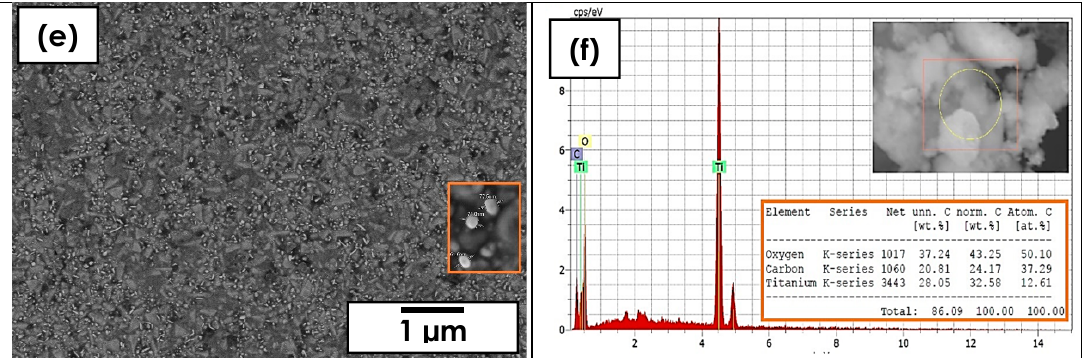
Figure 4. FESEM images of ( a ) graphite, ( b ) GO, ( c ) rGO, ( d ) TiO 2 , rGO-Ti ion implanted ( e ) at 120 °C, and ( f ) EDX data.